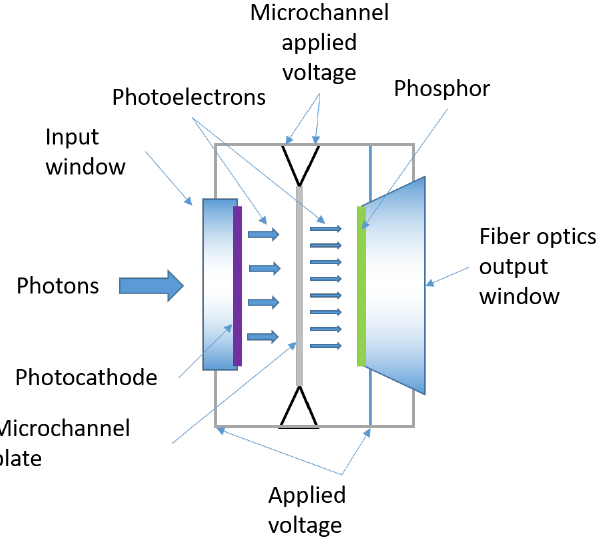
Figure 19. Intensified CCD (ICCD)